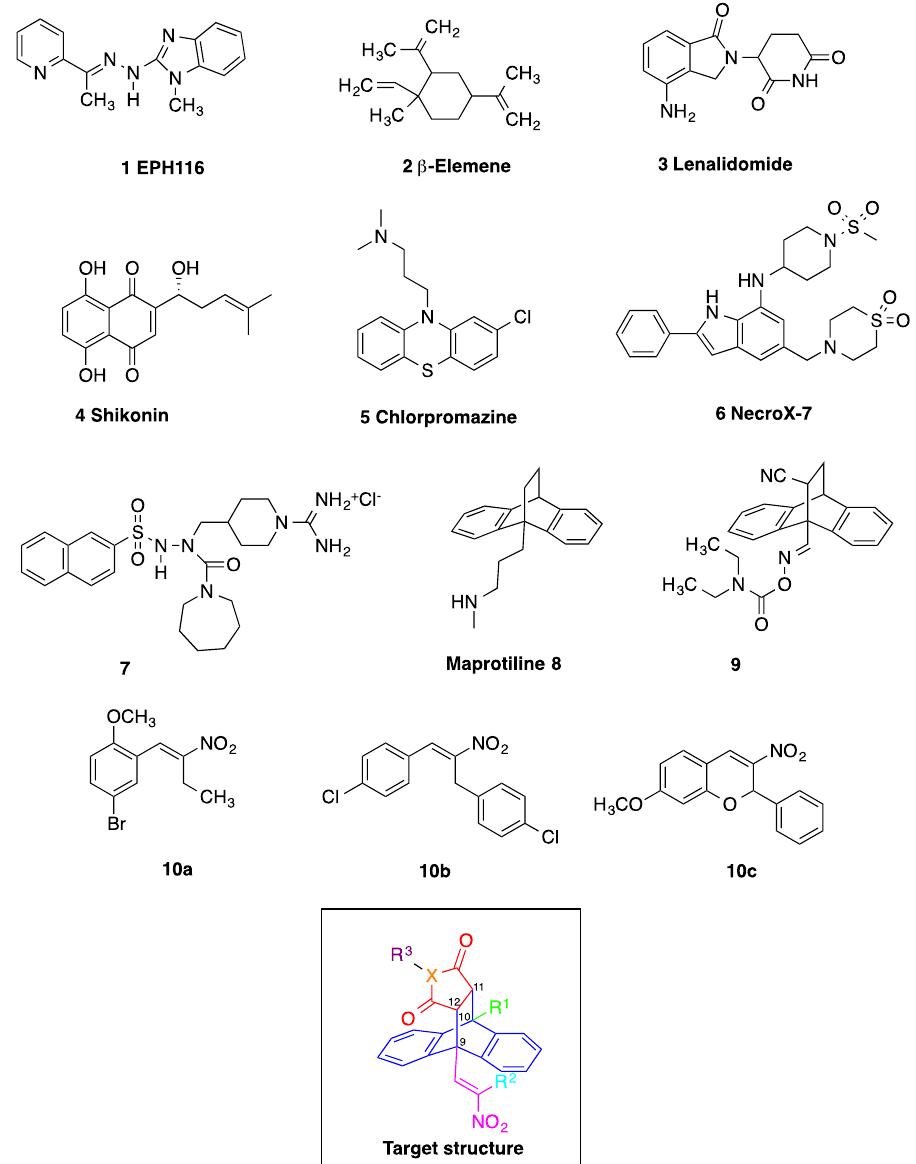
Figure 1. Chemical structures of compounds with reported activity against Burkitt’s lymphoma: compounds 1 – 7 , maprotiline 8 , ethanoanthracene 9 and nitrostyrene lead compounds 10a – c with target ethanoanthracene structure.